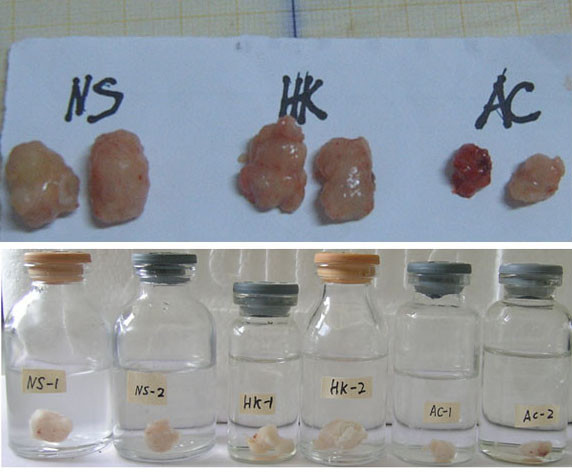
Comparison of the size of harvested implanted tumors in nude mice treated with NS, Ad-HK, or Ad-RhoA-RhoC. A: fresh anatomized B: formalin-fixed.